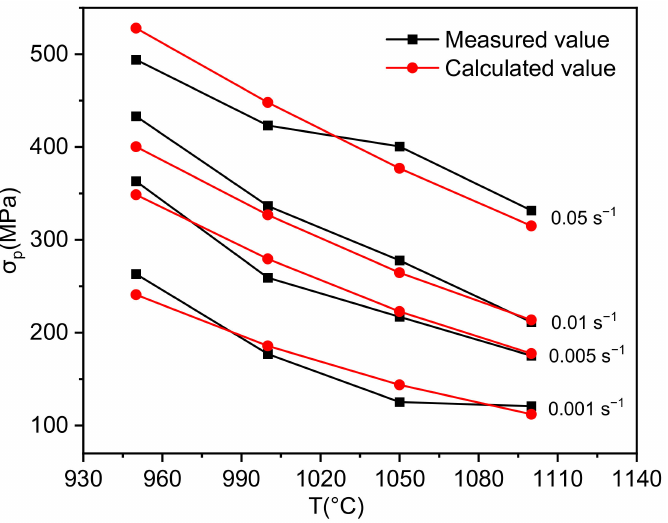
Figure 7. Comparison of measured and calculated peak stress of Inconel